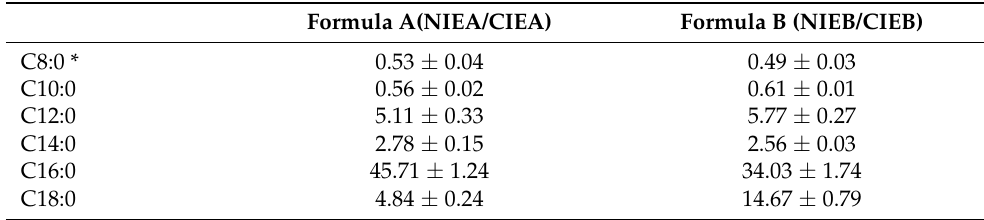
Table 2. FACs of two different formulas before and after CIE